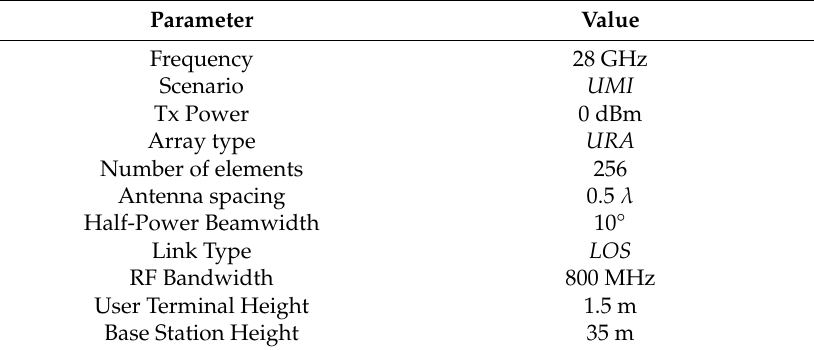
Figure 2. Illustration of our mmWave model ( left ) and the channel model ( right ). The channel model follows the NYU Wireless Group mmWave channel model [11]. Table 2. NYUSIM simulation parameters used for the channel simulations.